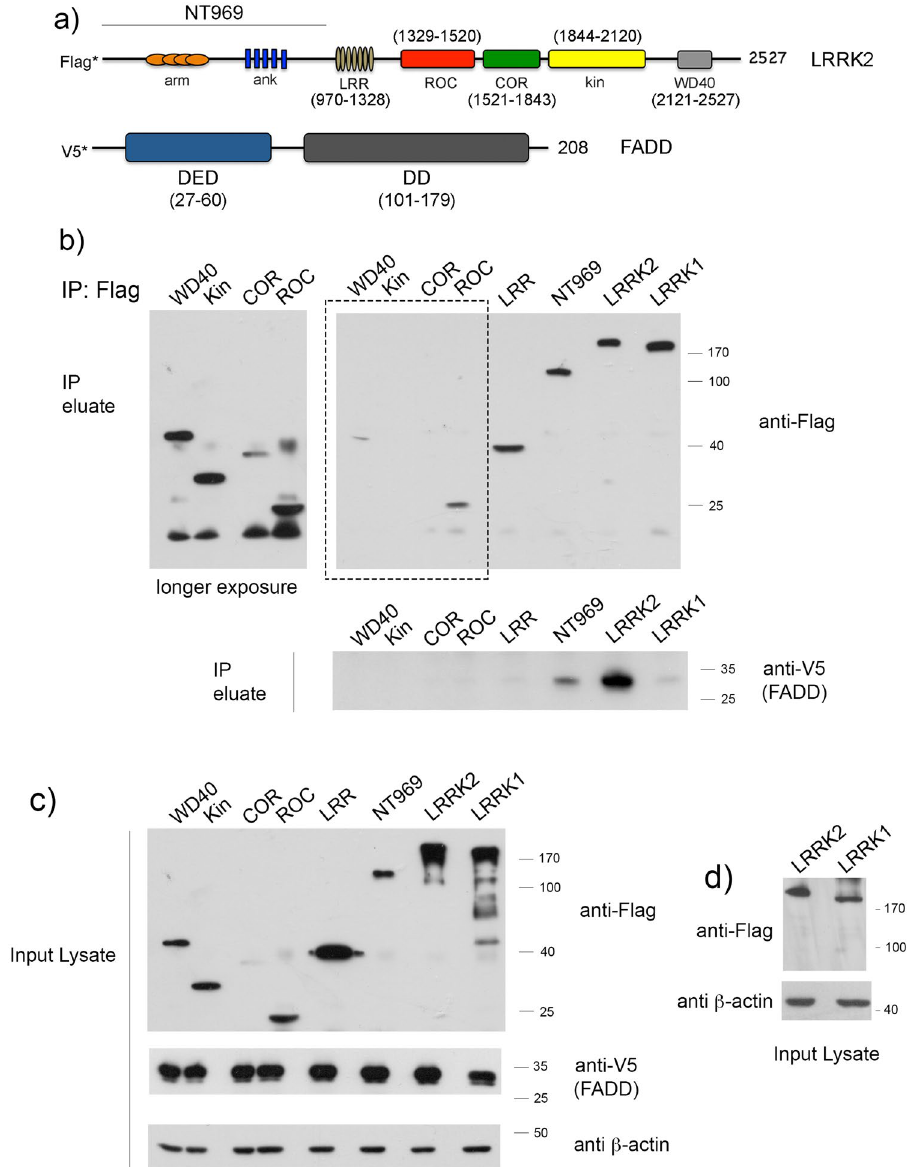
Figure 3. The N-terminal region upstream of the LRRK2 leucine-rich repeat interacts with FADD. ( a ) A schematic of the domain structure of LRRK2 with amino acid boundaries used in this study to map the interacting domain with FADD (lower schematic). ( b ) V5-tagged FADD was co-expressed in HEK293T cells with Flag-tagged LRRK1, or Flag-tagged constructs of LRRK2, encoding the full-length protein, or each of the discrete domains as illustrated in ( a ). Cell lysates were incubated with anti-Flag resin and the inputs and eluates were separated by 12% SDS-PAGE, followed by probing the membranes with anti-V5, anti-Flag, or anti- β -actin. The upper blots show the immunoprecipitation of Flag-LRRK1 or Flag-LRRK2 and probed for anti-Flag, and the co-precipitation of V5-FADD is shown in the middle panel (IP eluate) probed with anti-V5. FADD interacts with full-length LRRK2, but not the related LRRK1, and binds only the N-terminal domain upstream of the LRR. The left blot (in panel [b]) shows a longer exposure of the region highlighted by the box. Identical amounts of protein from the input lysate from each sample was separated by 12% SDS-PAGE, and the membranes probed with anti-Flag, anti-V5, and anti β -actin ( c ). In the blot shown in ( d ), identical lysates from cells expressing Flag-LRRK1 or Flag-LRRK2 were separated by 8% SDS-PAGE, to allow better separation of the LRRK1 and LRRK2